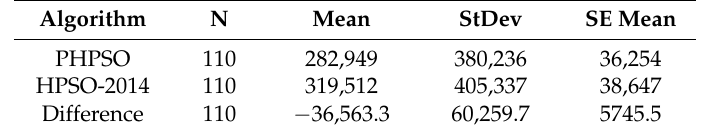
Table 4. Paired t -test for H 0 = PHPSO = HPSO vs. H 1 = PHPSO (cid:54) = HPSO on the best-known solutions. Algorithm